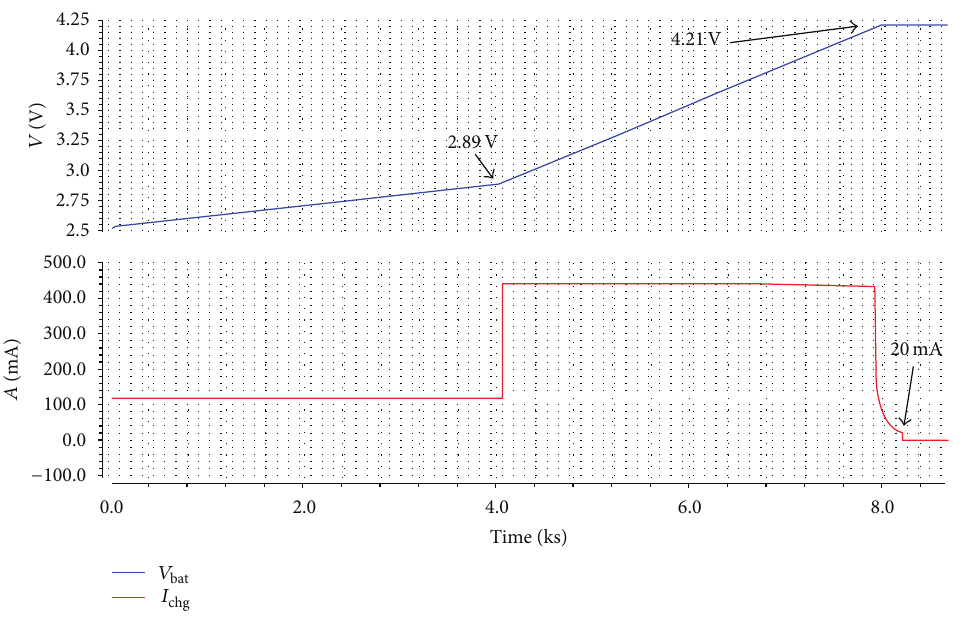
Figure 10: Simulation results of output voltage and current; from top to bottom, the waveforms are the battery voltage 𝑉 , current 𝐼 chg